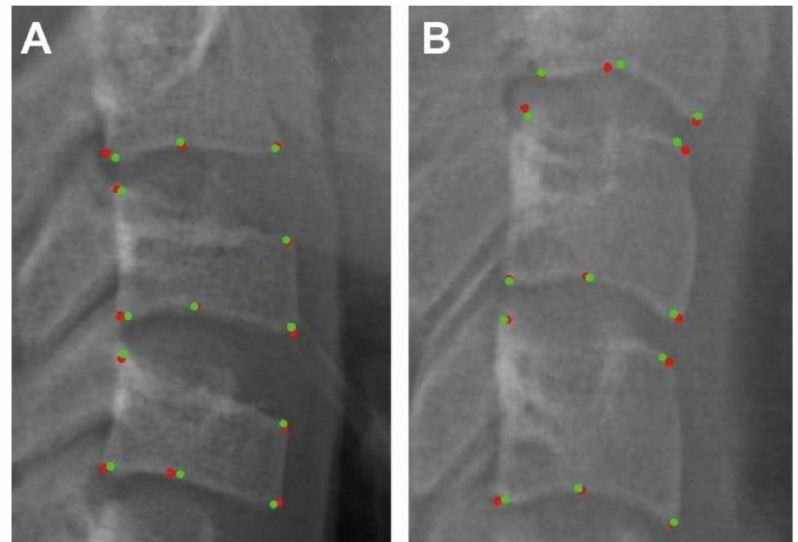
Figure 4. CNN output results: Anatomic landmarks that AI (points in red) and human (points in green) labelled in testing dataset. ( A ). AI and human labelled landmarks for CS 3 ( B ). AI and human labelled landmarks for